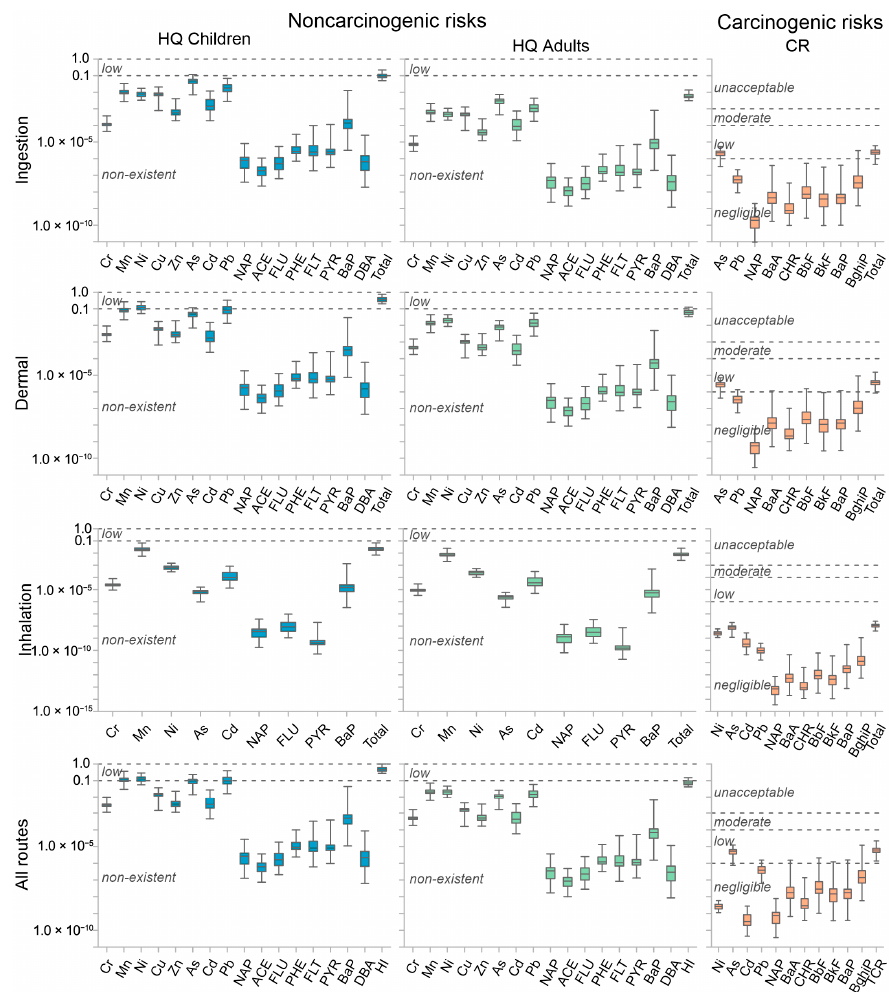
Figure 5. Boxplots of human health risk indices for PTEs and PAHs in topsoils of the Lower Don floodplain and the Taganrog Bay coast. Hazard quotient ( HQ ), total hazard index ( HI ), carcinogenic risk ( CR ), and total carcinogenic risk ( TCR ).